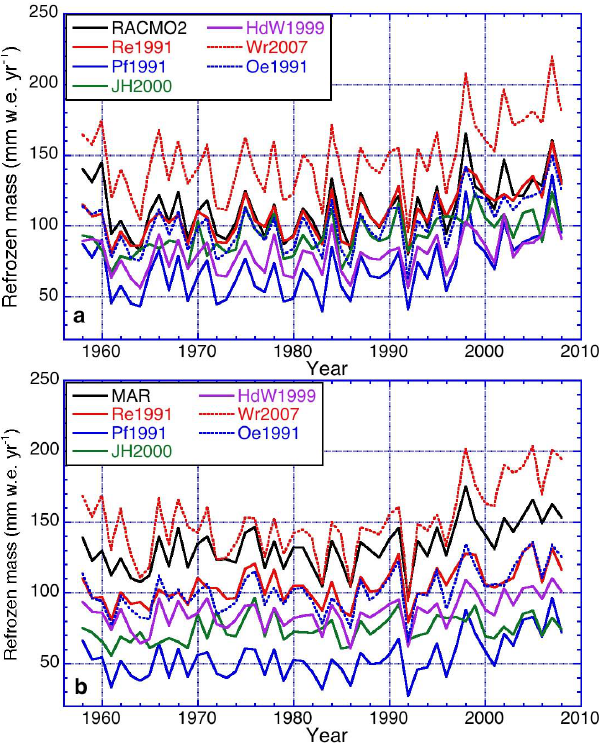
Fig. 6. Time series of ice sheet averaged annual sums of refrozen mass ( E r ) as modelled using the presented parameterizations. Using (a) RACMO2 and (b) MAR input fields.